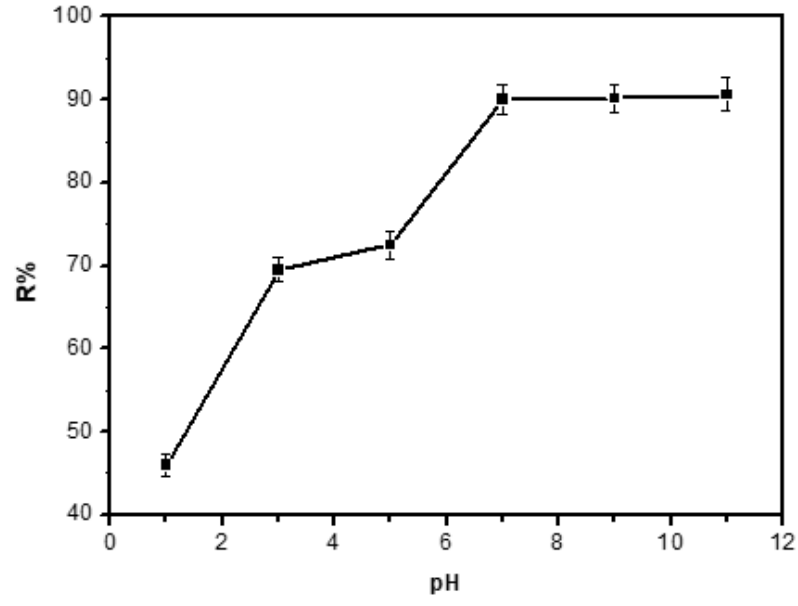
Figure 3. E ff ect of changing pH values on the e ffi ciency of removal of Ni(II) ions. Figure 3. Effect of changing pH values on the efficiency of removal of Ni(II) ions.